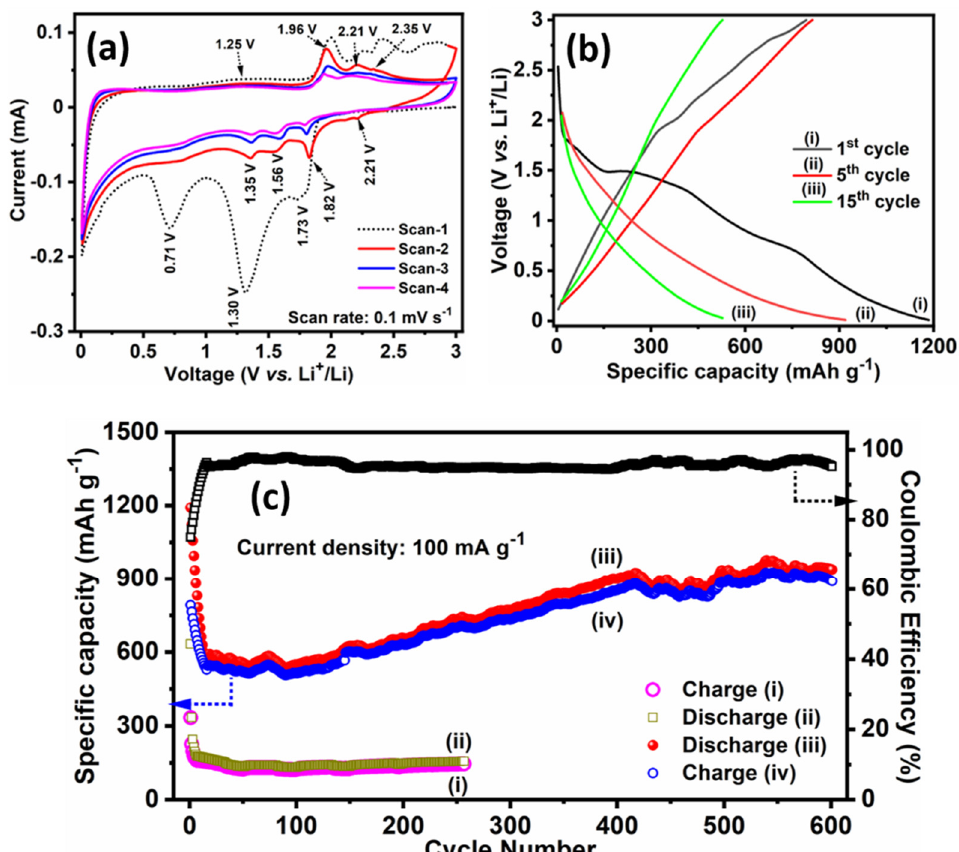
Figure 5. Half-cell LIB anode performance, ( a ) cyclic voltagram (CV) for first four cycles at 0.1 mV s − 1 of FNS@GC electrode, ( b ) galvanostatic charge-discharge curves for 1st, 5th, and 15th cycles of FNS@GC and 1st cycle for FNS electrode at 100 mA g − 1 current density at 0.01–3.0 V, and ( c ) cycling performance at 100 mA g − 1 current rate for pristine FNS (i & ii) and FNS@GC electrodes (iii & iv). The galvanostatic charge-discharge (GCD) for the FNS@GC sample was shown